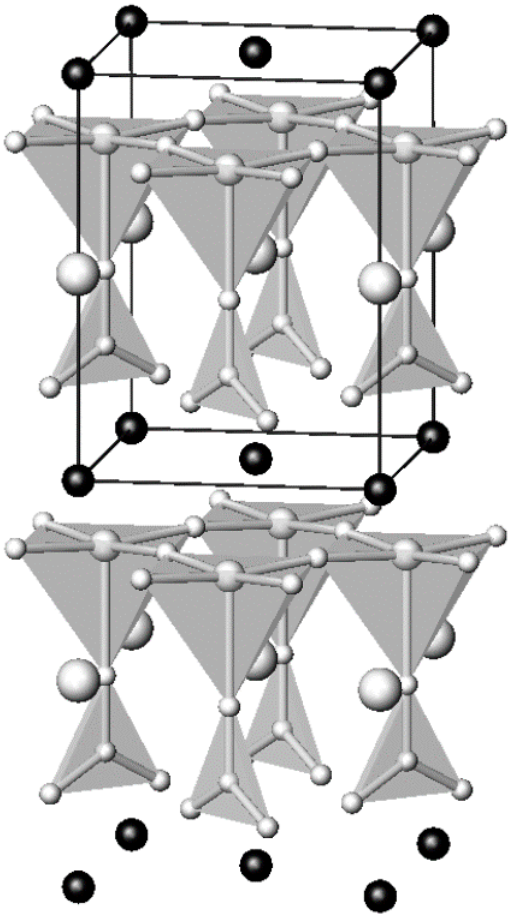
Figure 10. Crystal structure of NdBaCuO 2 BO 3 . Cu (pyramid) and B (triangular) coordination polyhedral are emphasized. Ba and Nd atoms are shown by light and dark circles, respectively. Reproduced with permission from [99], Figure 4.